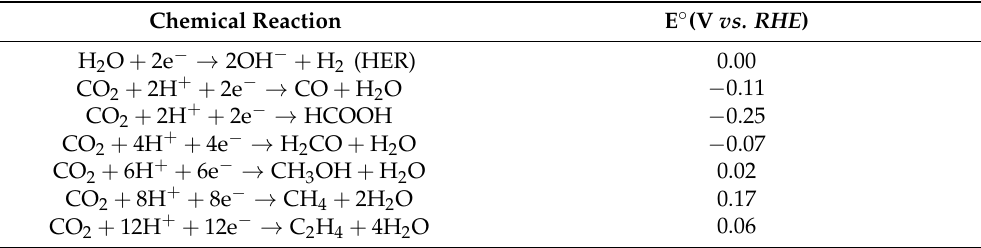
Table 1. Standard reduction potential (E ◦ ) at 25 ◦ C, 1 bar and pH = 7 for the CO 2 reaction reductions to several chemicals and the HER.